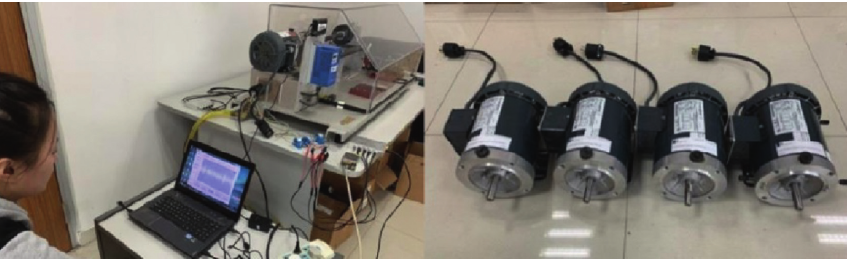
Figure 7: Motor fault data collection and fault motors.